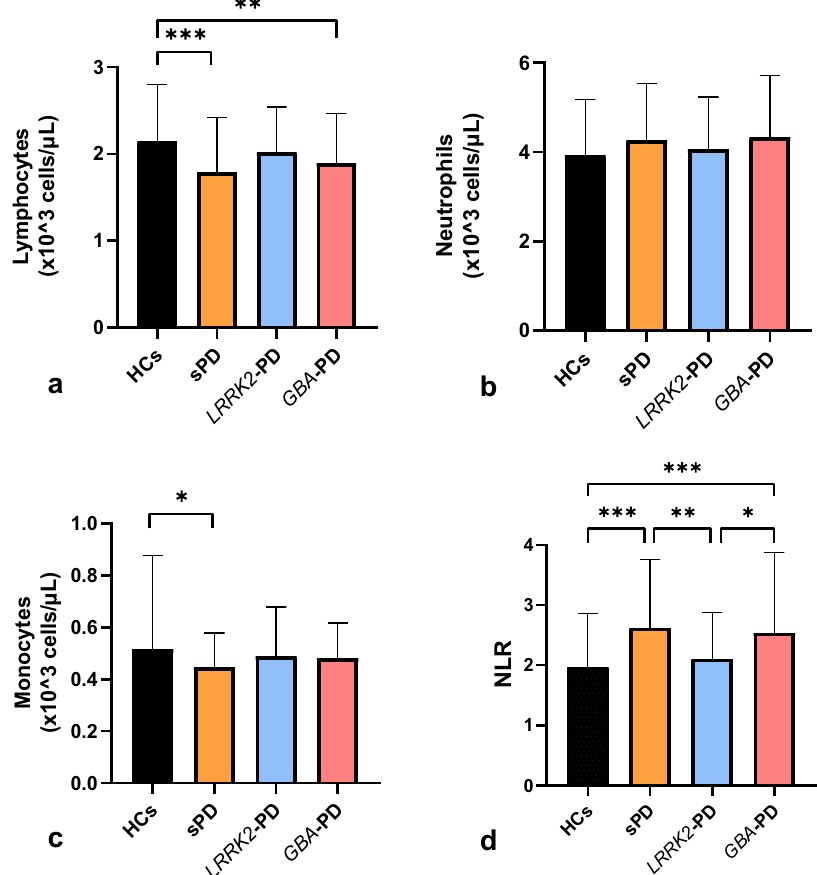
Fig. 1 Peripheral in fl ammatory immune pro fi le among sporadic and familial forms of Parkinson ’ s disease (PD) and healthy controls of the discovery cohort. *Multiple comparisons of lymphocytes ( a ), neutrophils ( b ), monocytes ( c ), and neutrophil-to-lymphocyte ratio (NLR) ( d ) among healthy controls (HCs), sporadic PD patients (sPD), GBA -associated PD patients ( GBA -PD, and LRRK2 -associated PD patients ( LRRK2 -PD). Numbers shown as means ± SD with multivariate lineal regression and post hoc testing for multiple comparisons as appropriate. *** p < 0.001, ** p < 0.05, * p ≤